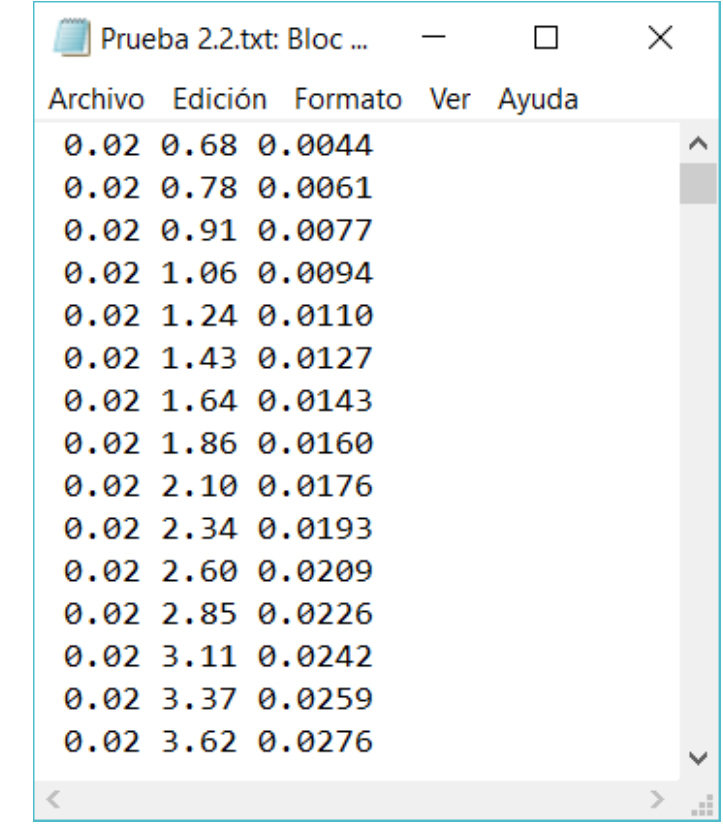
Figure 8. Results from a measurement carried out with ABDAS. Text file example. Two channels measured (two first column). The third column indicates the time of each measurement point (expressed in seconds).